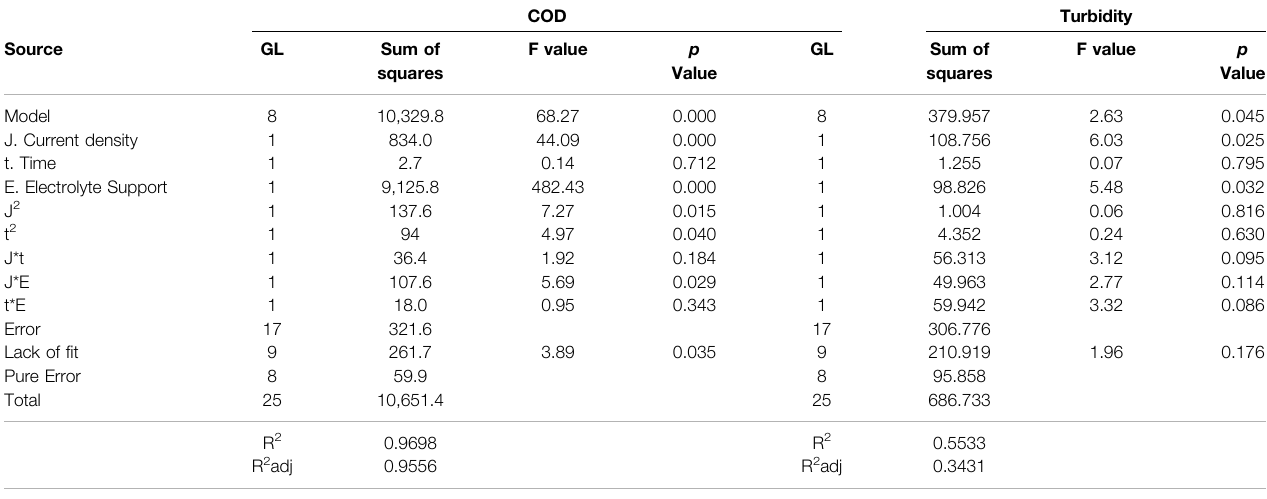
TABLE 2 | ANOVA for quadratic model